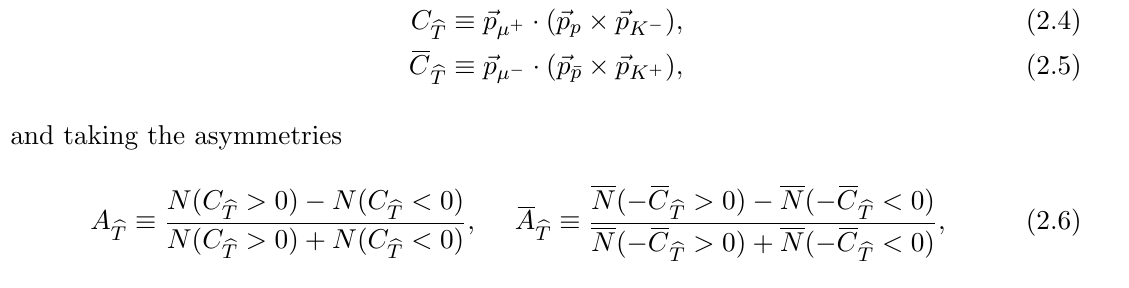
Imperfect cancellation in the production and reconstruction asymmetries can arise from di(cid:11)erences in the kinematic distributions of the signal and control modes. A weighting pro- cedure, discussed in section 5, is applied to correct for this, with residual e(cid:11)ects considered as a source of systematic uncertainty in section